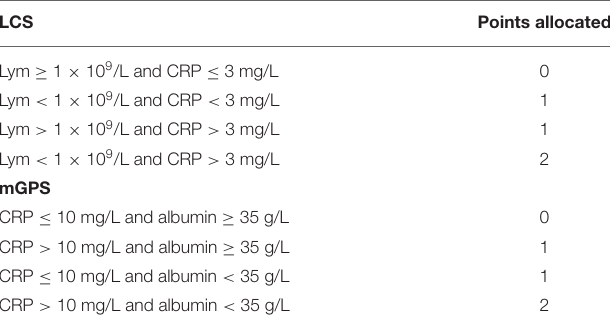
TABLE 1 | Two types of systemic inflammation-based prognostic scores. LCS Points